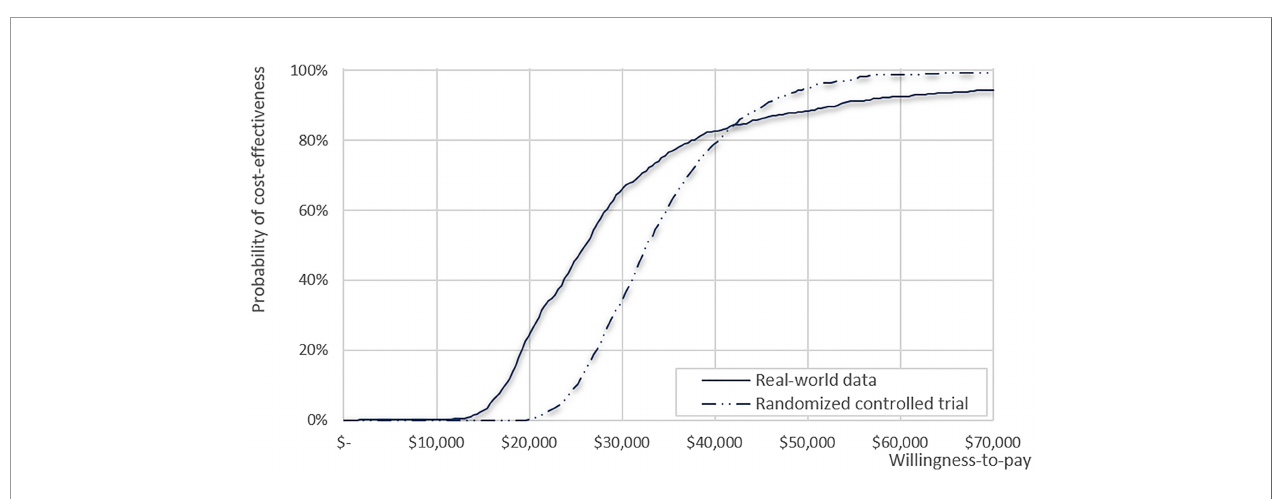
FIGURE 3 | Cost-effectiveness acceptability curve for clinical data from the real-world data and randomized clinical trial.